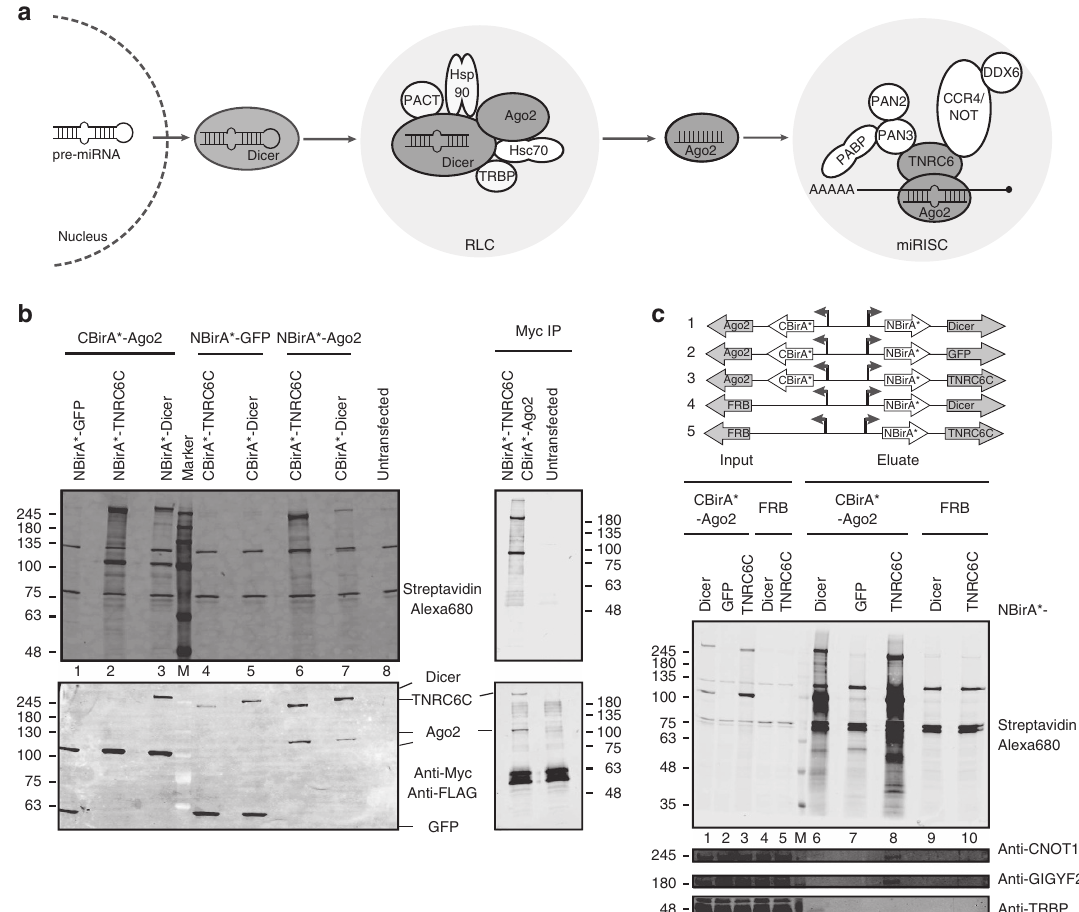
Figure 5 | Monitoring maturation of the miRISC with split-BioID. ( a ) Schematic of the miRNA-mediated silencing pathway. Main protein components of the RLC and miRISC are indicated. Dark grey circles are the proteins used for split-BioID. ( b ) Left, blots of lysates of cells transfected with the indicated combinations of fusion proteins. CBirA*-Ago2 combined with NBirA* fused to Dicer, TNRC6C or GFP showed the best interaction-induced biotinylation and was thus used further (See Supplementary Fig. 4). Right, immunoprecipitation of Myc-tagged NBirA*-TNRC6C from transfected or control cells. ( c ) Streptavidin capture of the biotinylated proteins from the CBirA*-Ago2/NBirA*-Dicer, -TNRC6C and -GFP samples. As controls, NBirA*-Dicer and -TNRC6C were also expressed in the absence of CBirA* fragments (replaced by FRB). CNOT1 and GIGYF2 were specifically detected in the Ago2/TNRC6C sample and TRBP in the Ago2/Dicer